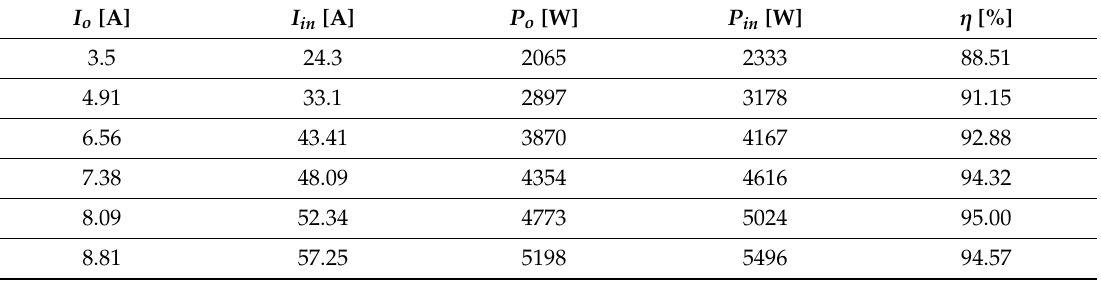
Figure 17. E ffi ciency of the converter for constant load / variable duty cycle (top) and constant duty Figure 17. Efficiency of the converter for constant load/variable duty cycle (top) and constant duty cycle / variable load (bottom). cycle/variable load (bottom). Table 4. E ffi ciency results with constant output